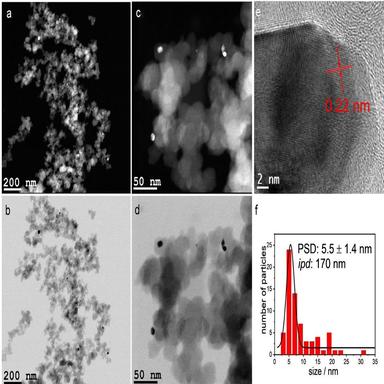
Representative (a and c) virtual high-angle angular dark field (images reconstructed from electron diffraction patterns), (b and d) bright-field STEM, and (e) HR-TEM images of Pd1%/PCL6. (f) Size distribution histograms and interparticle distance (ipd) for Pd1%/PCL6.